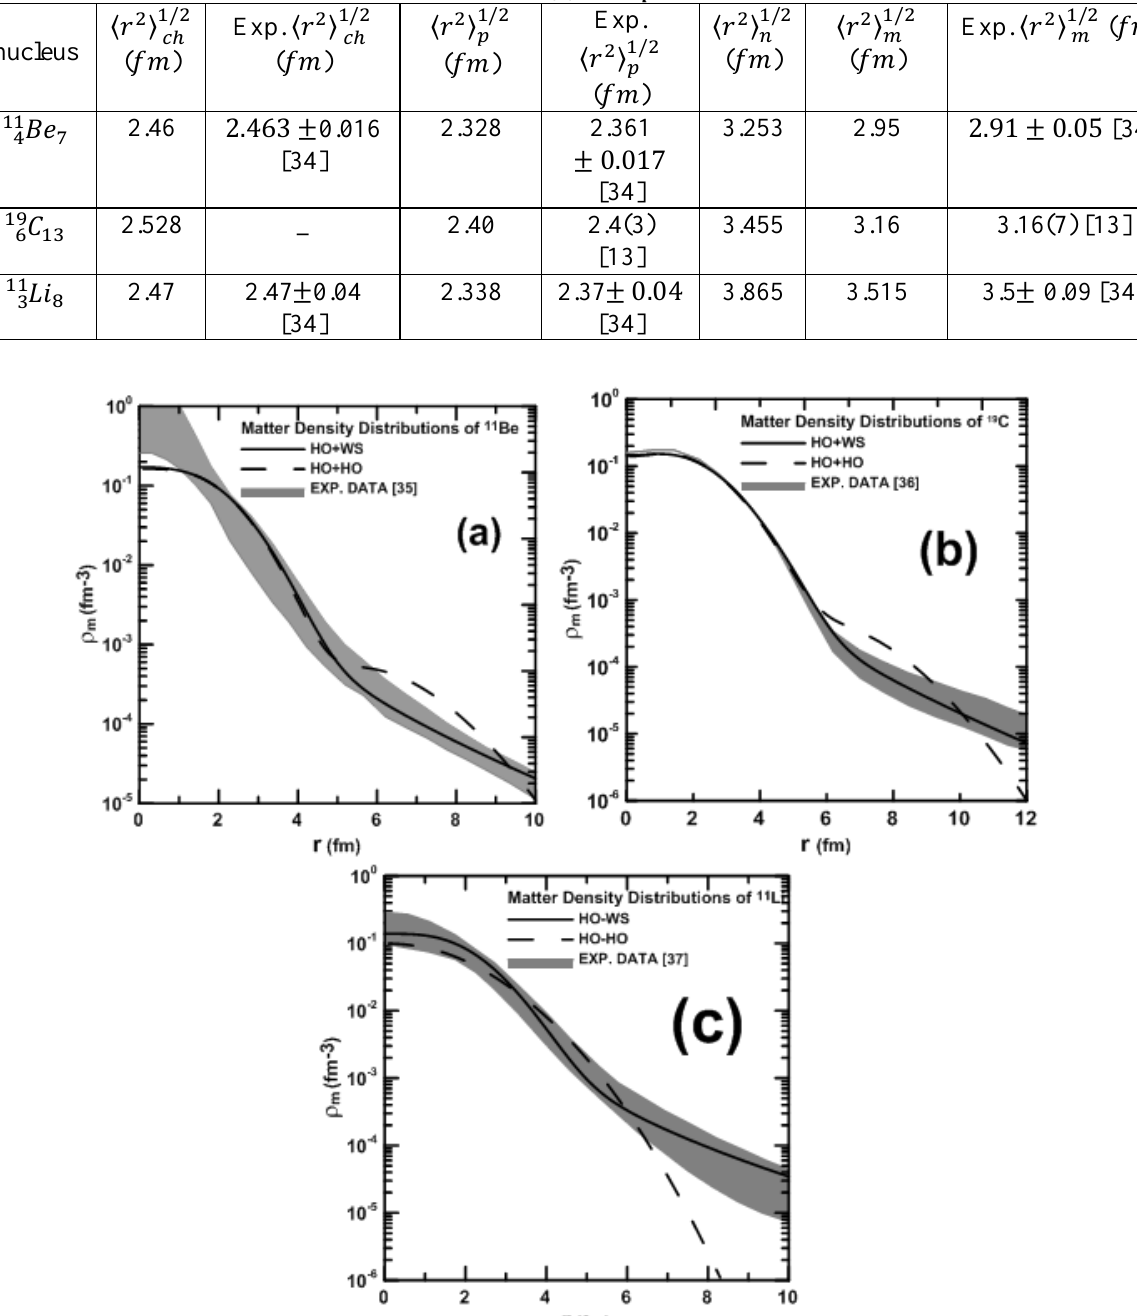
Table 3: The calculated 〈